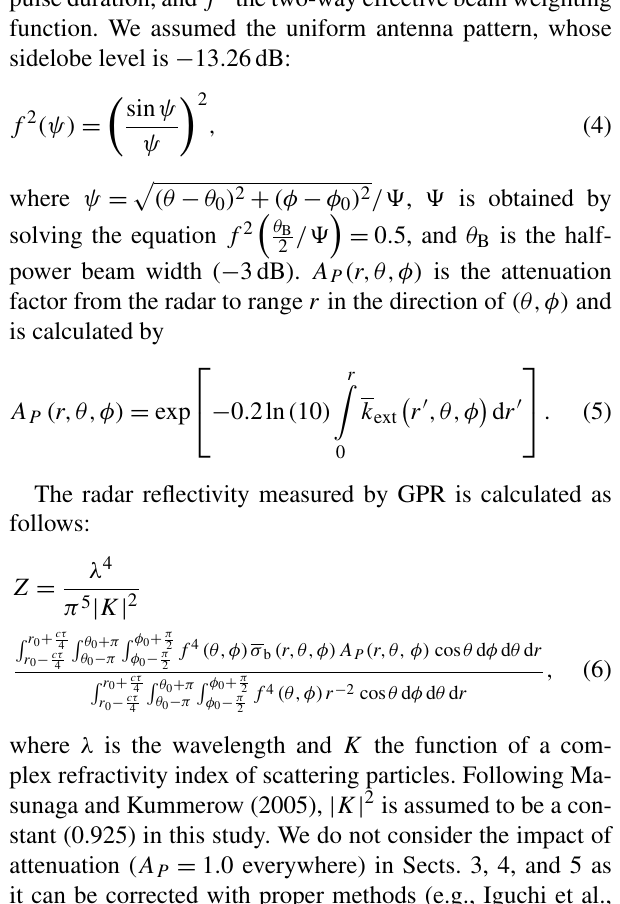
20km at nadir Observation range 30km at